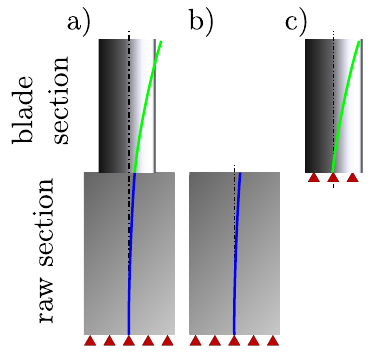
Figure 3. Schematic representation of the coupled beam model ( a ) and the two separated components ( b , c ). The assumed deformation is represented by blue and green curves in the raw and the blade parts, respectively.